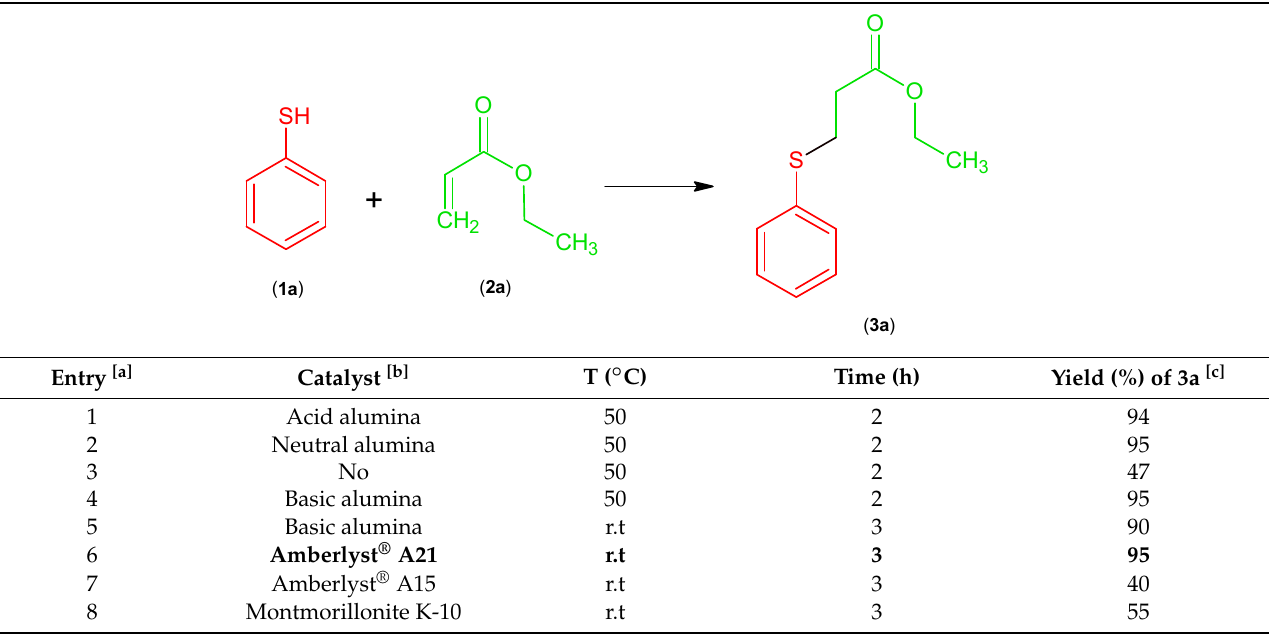
Table 1. Optimization runs of model reaction between thiophenol ( 1a ) and ethyl acrylate ( 2a ) to yield product ( 3a ).